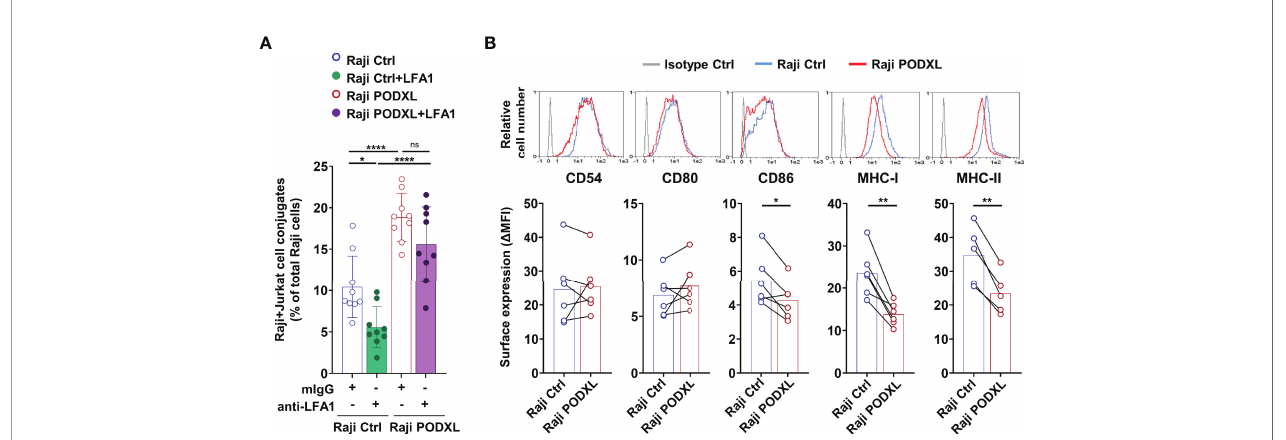
FIGURE 5 | PODXL decreases the expression of CD86, MHC-I and MHC-II in APCs. (A) Raji-PODXL, Raji-Ctrl cells and CMTMR-labeled Jurkat cells were preincubated separately with a blocking anti-LFA-1 monoclonal antibody for 15 min. Afterwards, Raji-PODXL and Raji-Ctrl were mixed with CMTMR-labeled Jurkat cells at a ratio of 1:1 and incubated for 30 min. The percentage of Raji-Jurkat cell conjugates was determined by fl ow cytometry as in ( Figure 4A ). Bar graph represents the mean ± SD of nine independent experiments. *p < 0.05, ****p < 0.0001, one-way ANOVA. (B) Raji cells overexpressing PODXL and Raji Ctrl cells were analyzed by fl ow cytometry for surface expression of CD54, CD80, CD86, MHC-I and MHC-II. Overlay histograms represent the surface expression of the indicated marker in Raji-PODXL cells (red line), Raji-Ctrl cells (blue line) and the isotype control (grey line). Graphs show mean ± SD of surface expression ( D MFI= Marker MFI - isotype control MFI) from six (CD54, CD80, CD86, MHC-I) or fi ve (MHC-II) independent experiments. *p < 0.05, **p < 0.01, paired t test. 0.0001, ns, not statistically signi fi cant; one-way